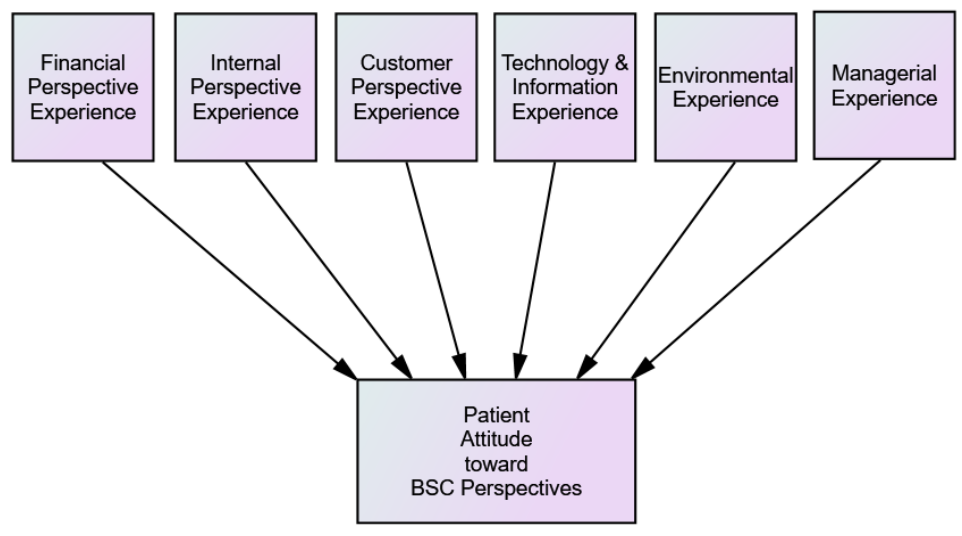
Figure 4. BSC-PATIENT conceptual model.